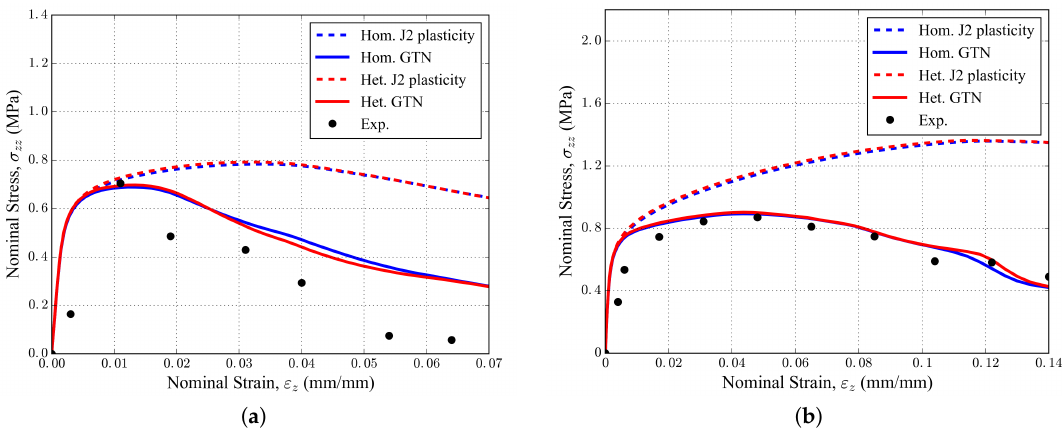
Figure 11. Macroscopic experimental and FE tensile curves of the ( a ) 20 PPI and ( b ) 30 PPI foam